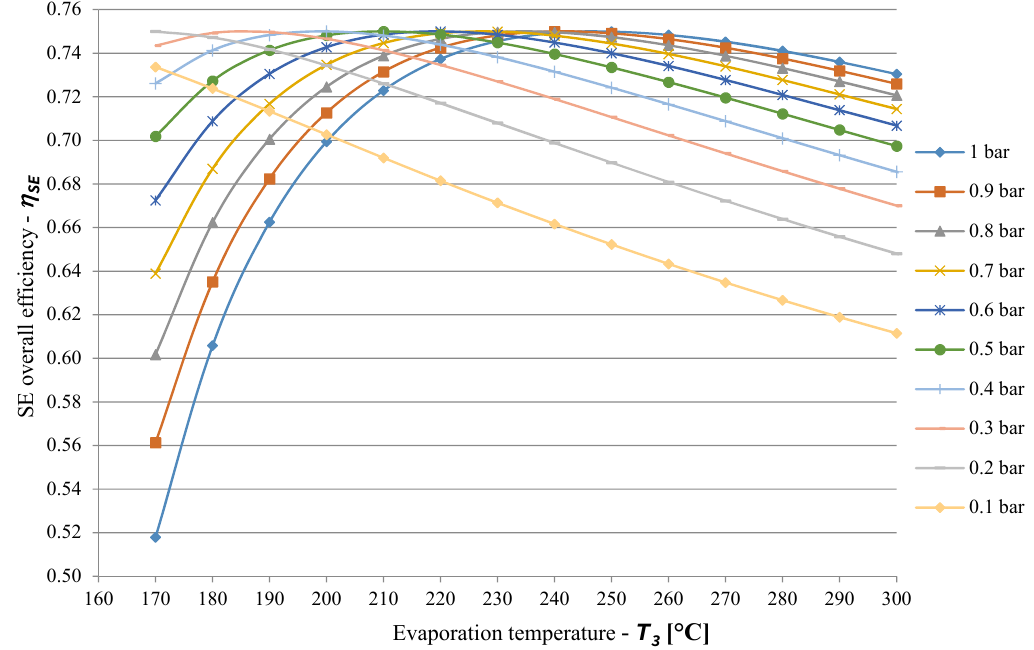
Figure 4. Screw expander overall efficiency calculated against evaporation temperatures and condensation pressures. Reprint with permission [2]; 2020, John Wiley and Sons.